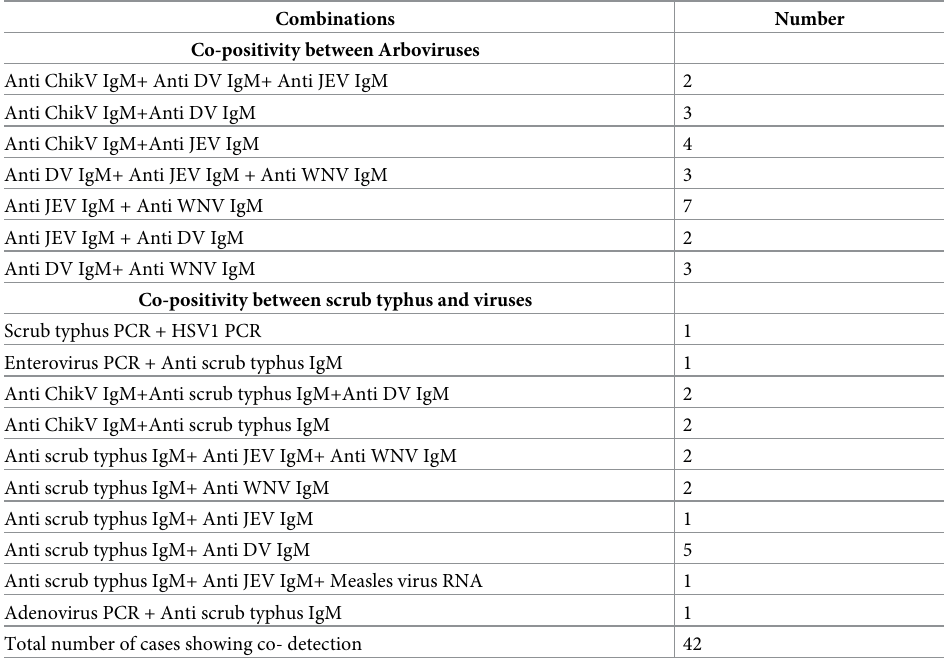
Table 4. Co detection of more than one pathogen: Combinations detected. Combinations Number Co-positivity between